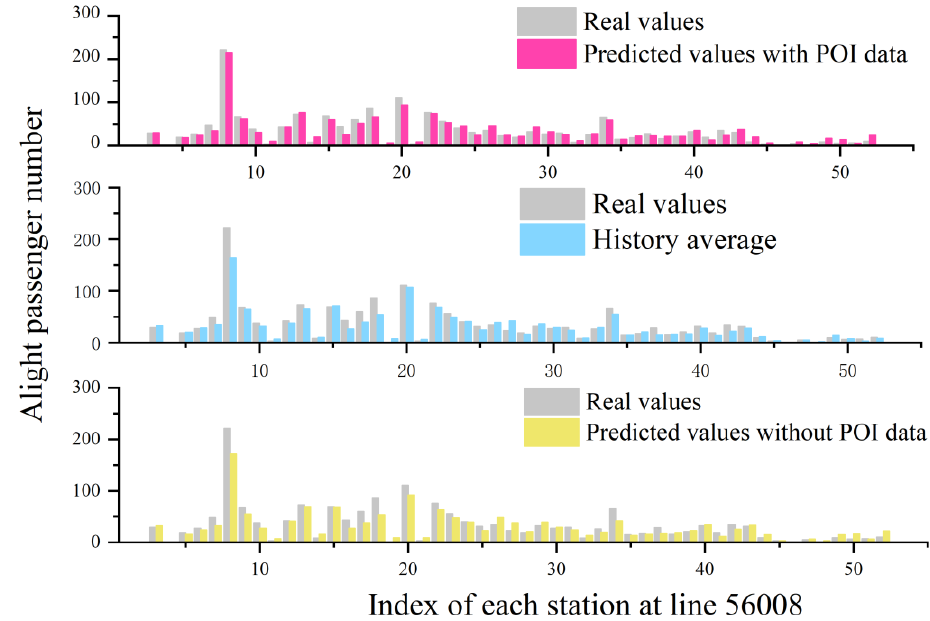
Figure 9. Predicted and true values of alighting passenger numbers using three models.